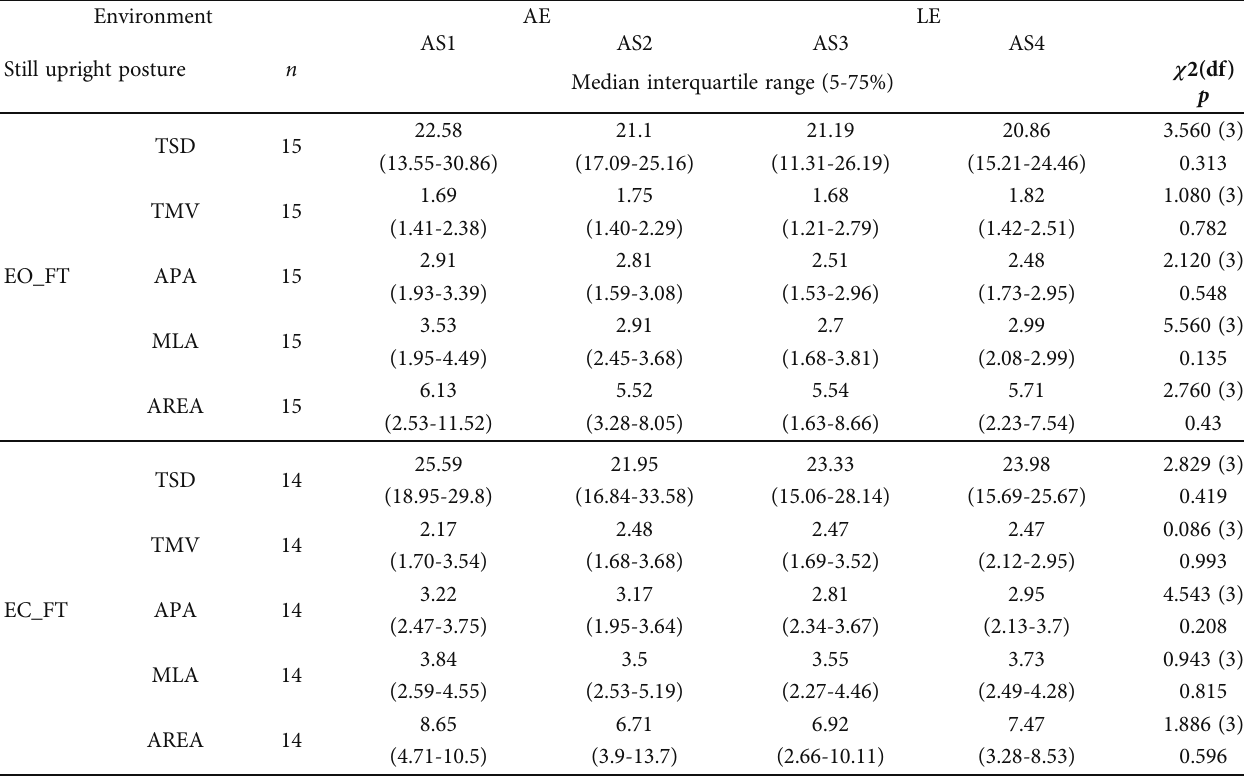
Table 4: Comparative analysis of postural control in a still upright posture in people with Parkinson ’ s disease after the sequential multimodal intervention program in aquatic and land